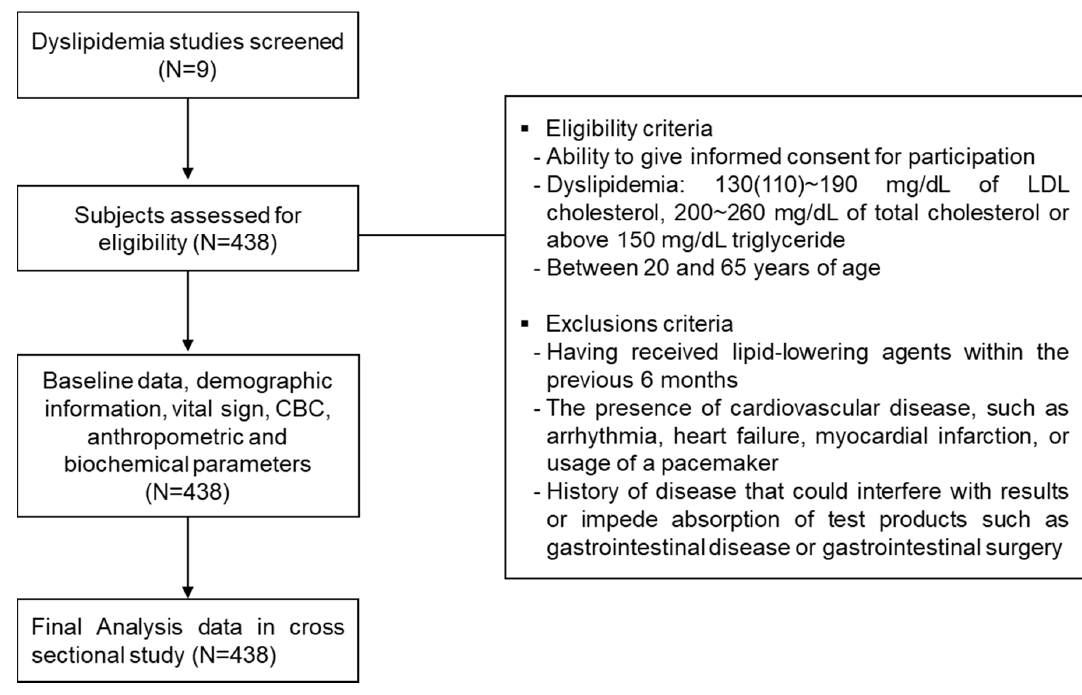
Figure 1. Flow diagram of study selection process.